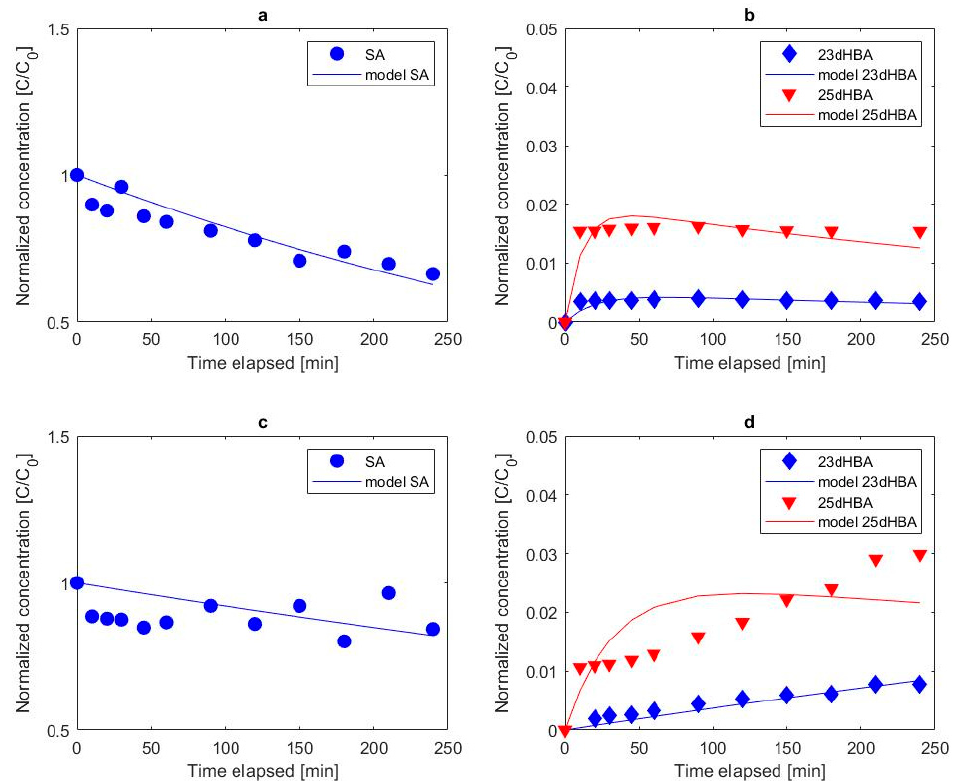
Figure 6. Experimental data and model with sulfate (Na 2 SO 4 ) as the supporting electrolyte: BDD anode ( a ) and ( b ), Pt anode ( c ) and ( d ); normalized concentrations with respect to initial SA concentration .